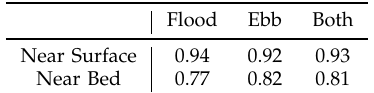
TABLE VI E STIMATE OF NORMALISED DAMAGE EQUIVALENT LOAD VALUES FOR MEASURED LOADS AT DIFFERENT ONSET FLOW SPEEDS , USING A RATIO BETWEEN RESULTS FROM VARYING MEASURED CASES WITH VARY TURBULENCE AND THE MEAN PREDICTED WITH CONSTANT TURBULENCE